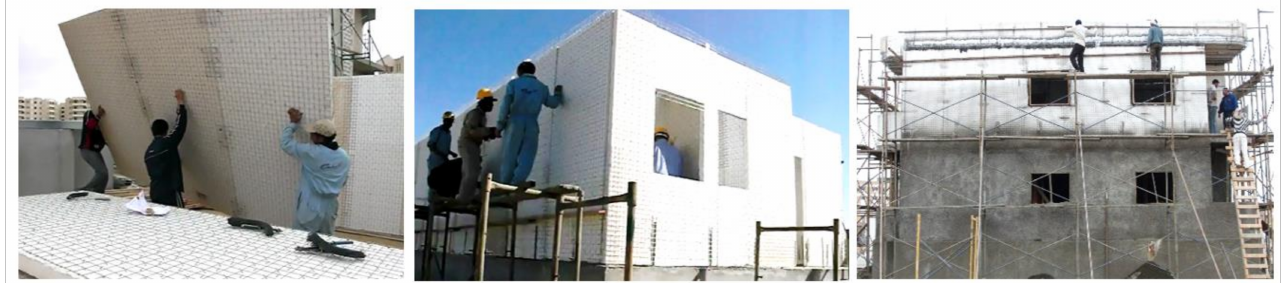
Figure 1. Light-weight feature of CSP building